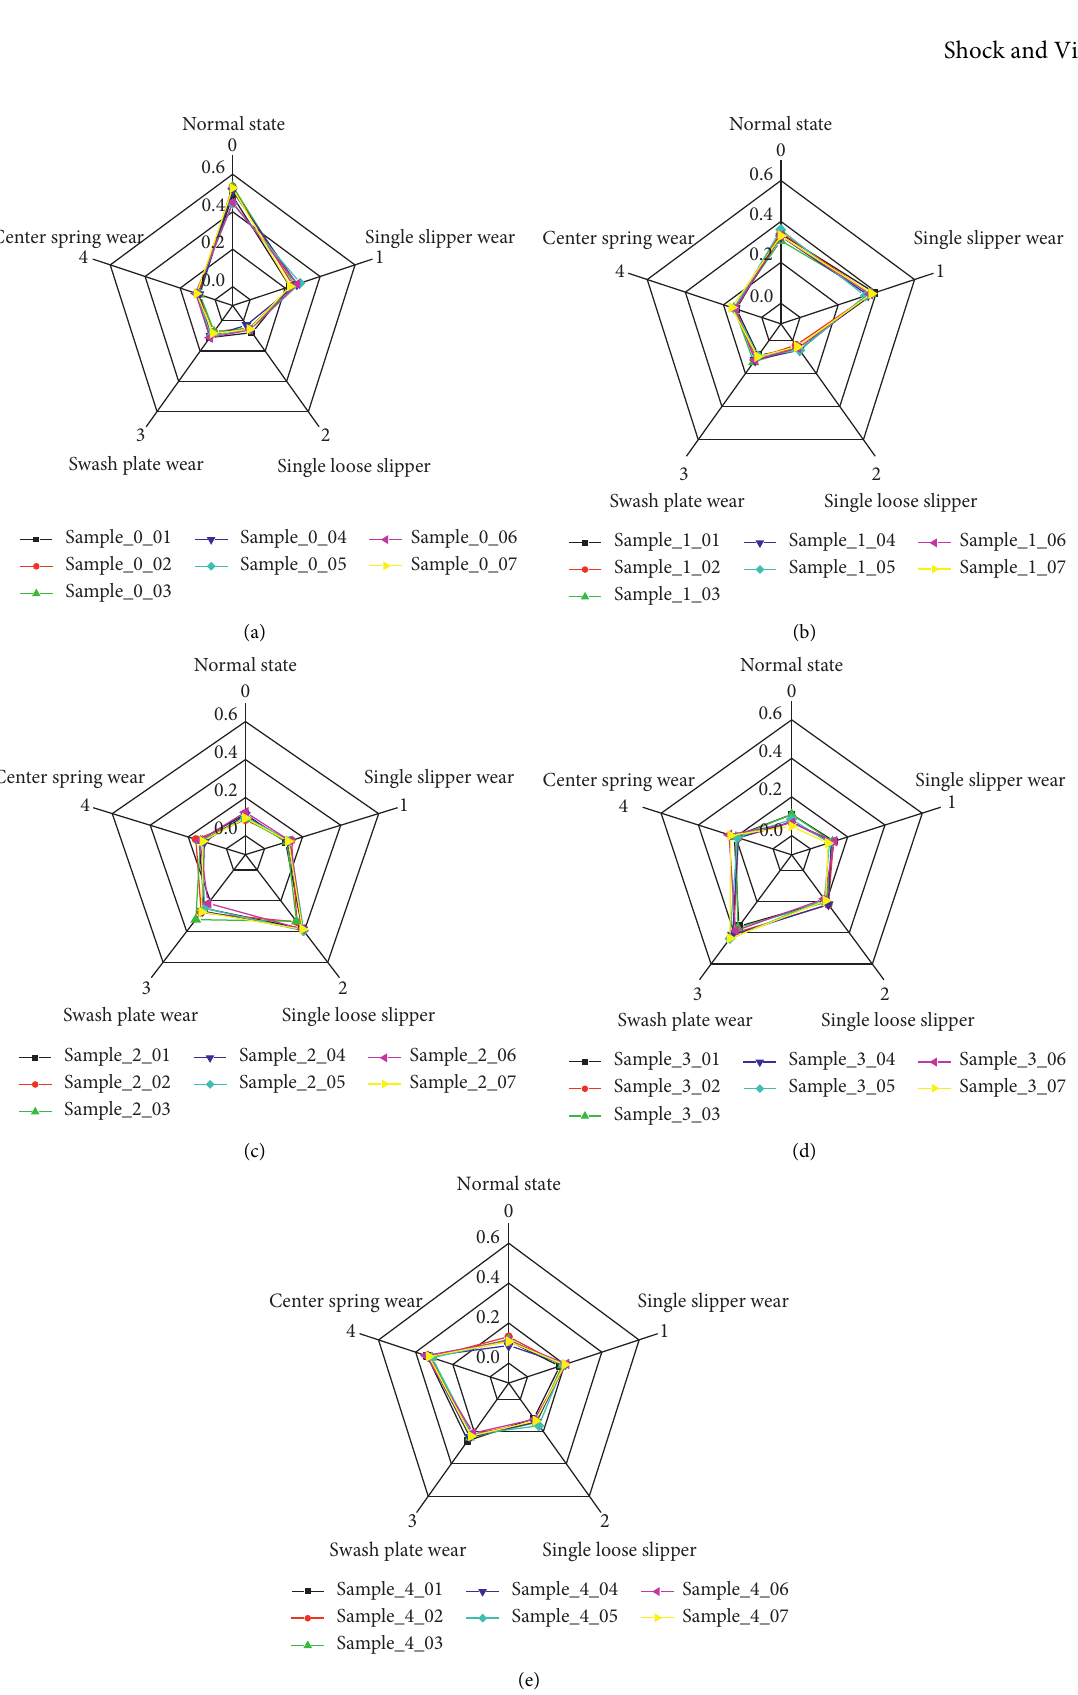
Figure 16: Test results of fault diagnosis model for axial piston pump. (a) The normal state of fault free. (b) The fault state of single slipper wear. (c) The fault state of single loose slipper. (d) The fault state of swash plate wear. (e) The fault state center spring